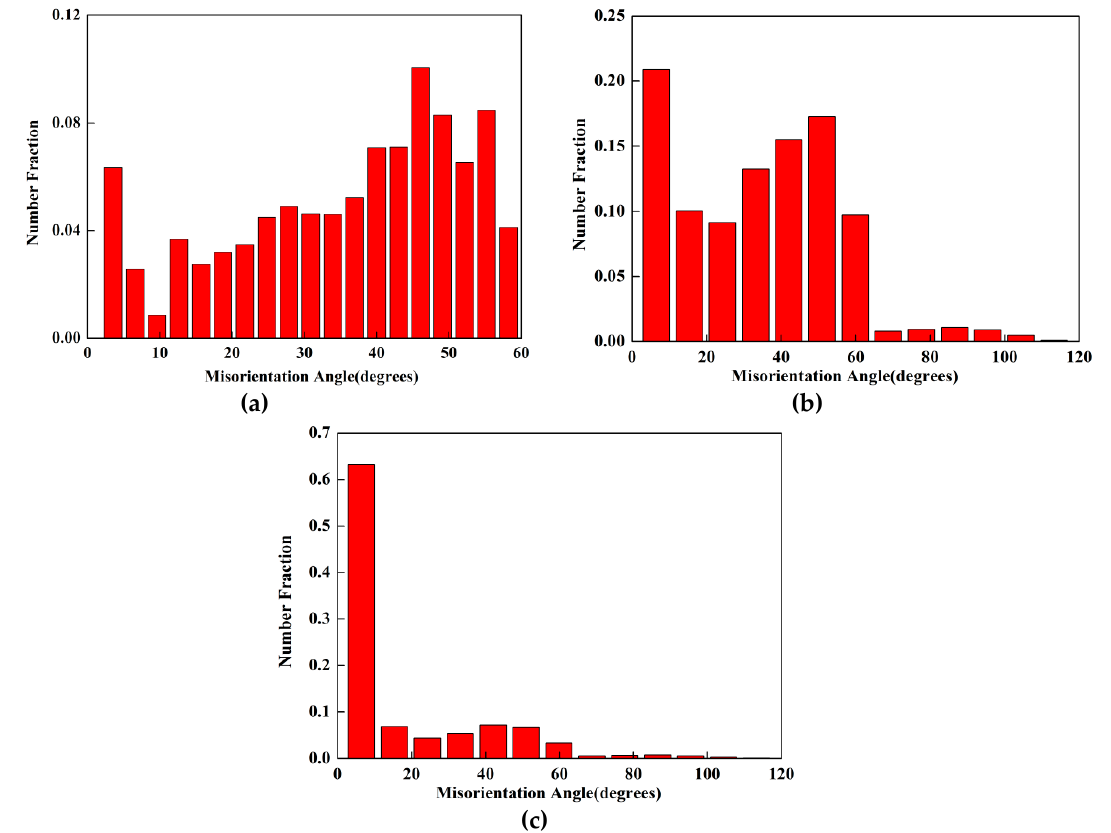
Figure 14. Misorientation distribution of grain boundaries in the initial phase zone with different deformation ratios; ( a ) ε = 0; ( b ) ε = 0.04; ( c ) ε = 0.607.